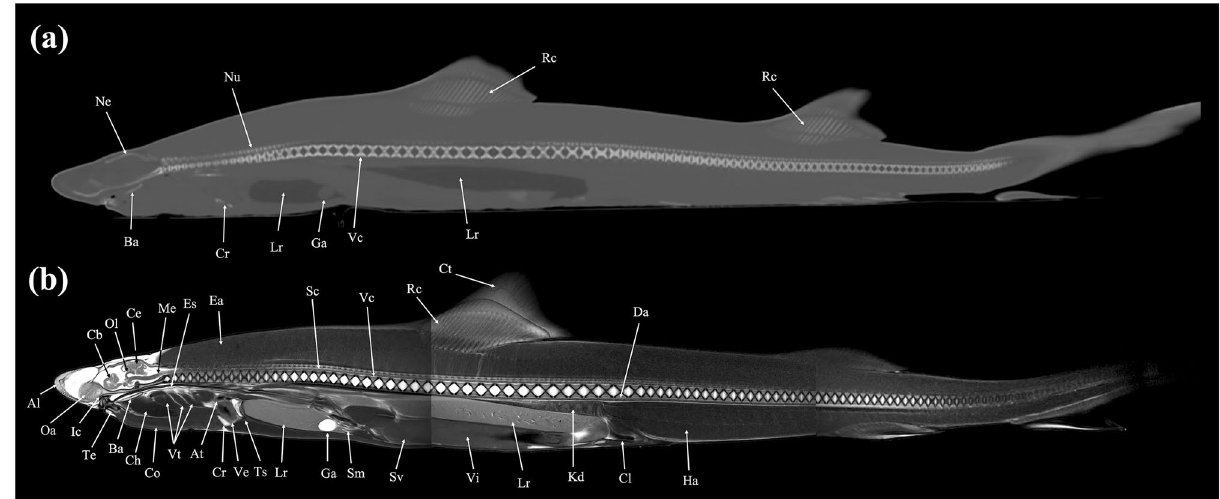
Figure 16. Mid-sagittal ( a ) CT and ( b ) MR images of a banded houndshark ( Triakis scyllium ) at level 16 of Fig. 25. Al Ampullae of Lorenzini, At Atrium, Ba Basihyal cartilage, Cb Cerebrum, Ce Cerebellum, Cl cloaca, Co Coracomandibularis, Cr Coracoid bar, Ch Coracohyoideus, Ct Ceratotrichia, Da Dorsal aorta, Ea Epaxial, Es Esophagus, Ga Gall bladder, Ha Hypaxial, Ic Internasal cartilage, Kd Kidney, Lr Liver, Me Medulla oblongata, Ne Neurocranium, Nu Neural arch, Oa Olfactory lamellae, Ol Optic lobe, Rc Radial cartilage, Sc Spinal cord, Te Teeth, Ts Transverse septum, Vi Valvular intestine, Ve Ventricle, Vt Ventral constrictors, Vc Vertebral centrum, Sm Stomach, Sv Spiral valve.